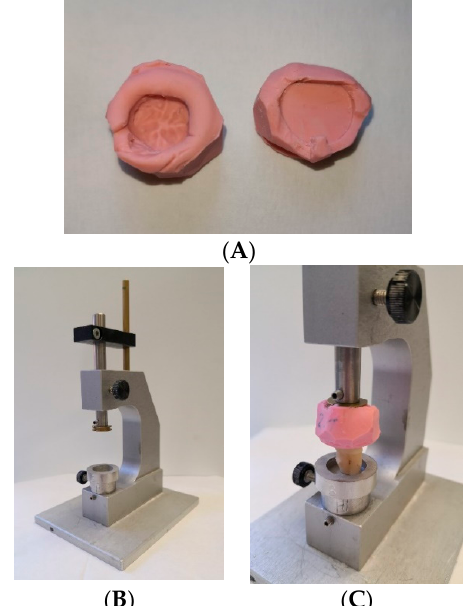
Figure 2. Identical positioning of specimens with same morphology. ( A ) Silicone impression: bottom side, crown of first embedded specimen; top side, asymmetrical disc. ( B ) Self-made device allowing for identical repositioning of further specimens. Vertical pin with mounted asymmetrical disc was locked so as to only allow vertical movements and no rotation. ( C ) Crown fitting into bottom side, asymmetrical disc fitting into top side of silicone impression, allowing for exact reproduction of specimen positions.